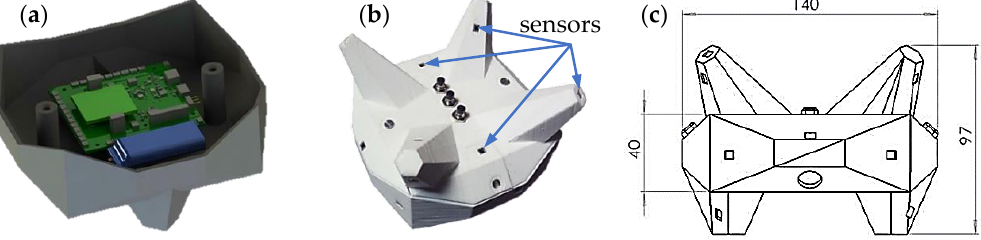
Figure 1. The lower part of the tracker model prepared for printing: with electronic components ( a ); a photo of the tracker prototype ( b ); and its dimensions (units—mm) ( c ).